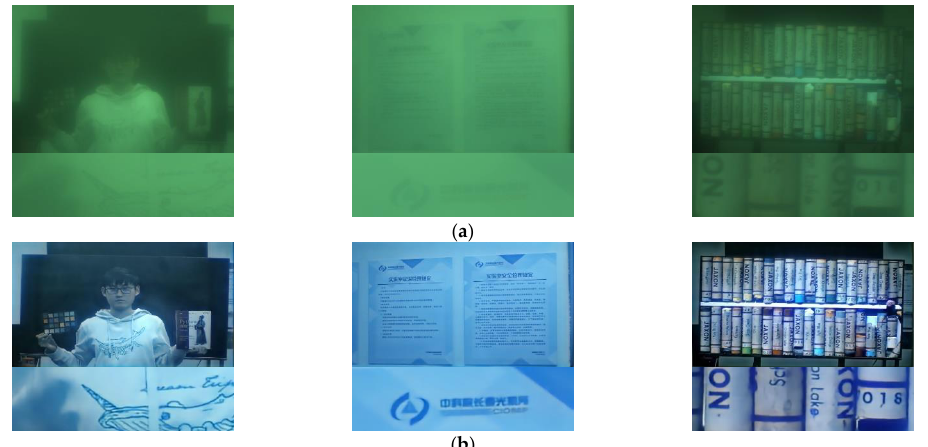
Figure 11. The restoring results in real scenes: ( a ) Images directly captured by single-convex-lens imaging system; ( b ) The restoring images processed by our restoring method.